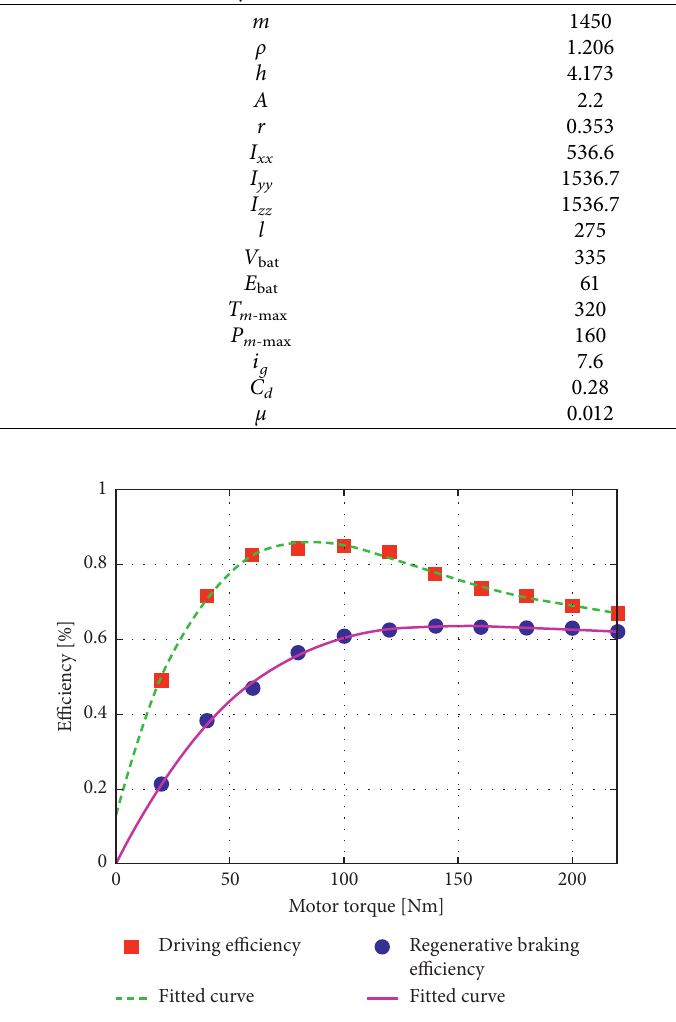
Figure 6: Driving efficiency and regenerative braking efficiency of